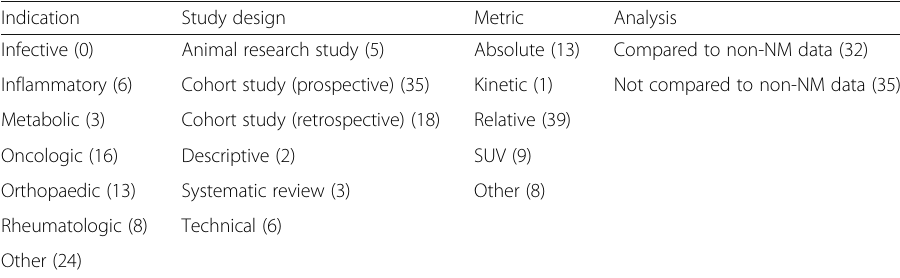
Table 1 Results from Literature Search 2, pertaining to 76 publications. Multiple criteria could be fulfilled by one study (number of publications in parentheses). ‘ NM ’ denotes ‘ nuclear medicine ’ . Seven papers could not be found in full or